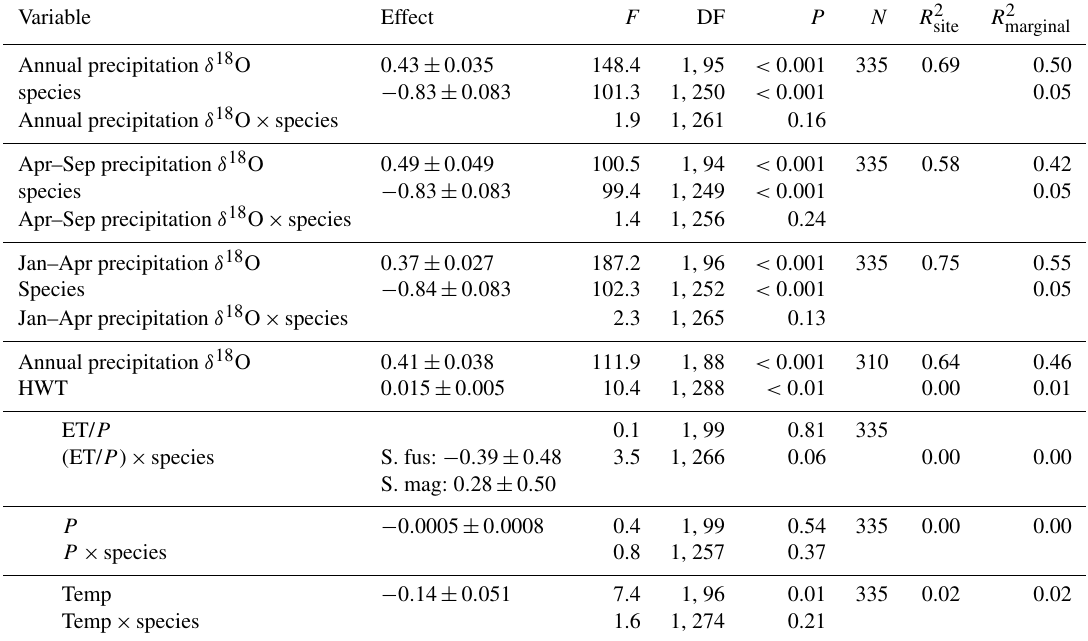
Table 3. Results from linear mixed models for δ 18 O values. Statistical tests are based on type-2 F test using Kenward–Roger-adjusted degrees of freedom. Three time periods for modelled δ 18 O values (‰) in precipitation were tested individually: annual mean, growing season (April–September) and spring (January–April). The three climatic variables (growing season sums and mean: ET/ P , P (mm), temp [ ◦ C]) were tested one by one in a model including HWT (cm) and mean annual δ 18 O values). Estimated effects ( ± SEs) are only given for the main effects if interactions were considered negligible. These effects are slopes for continuous variables (all variables except species) and for species (categorical) the difference between S. magellanicum and S. fuscum (i.e. S. fuscum being the reference level). R 2 between-site variance; R 2 is explained total marginal